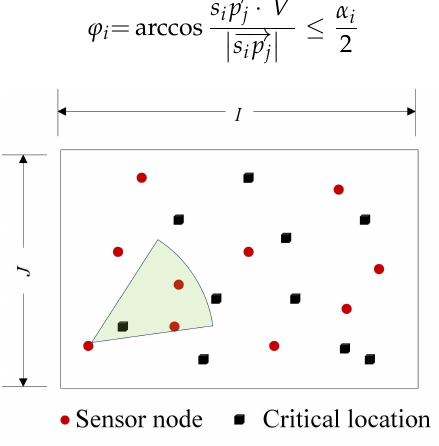
Figure 2. Network